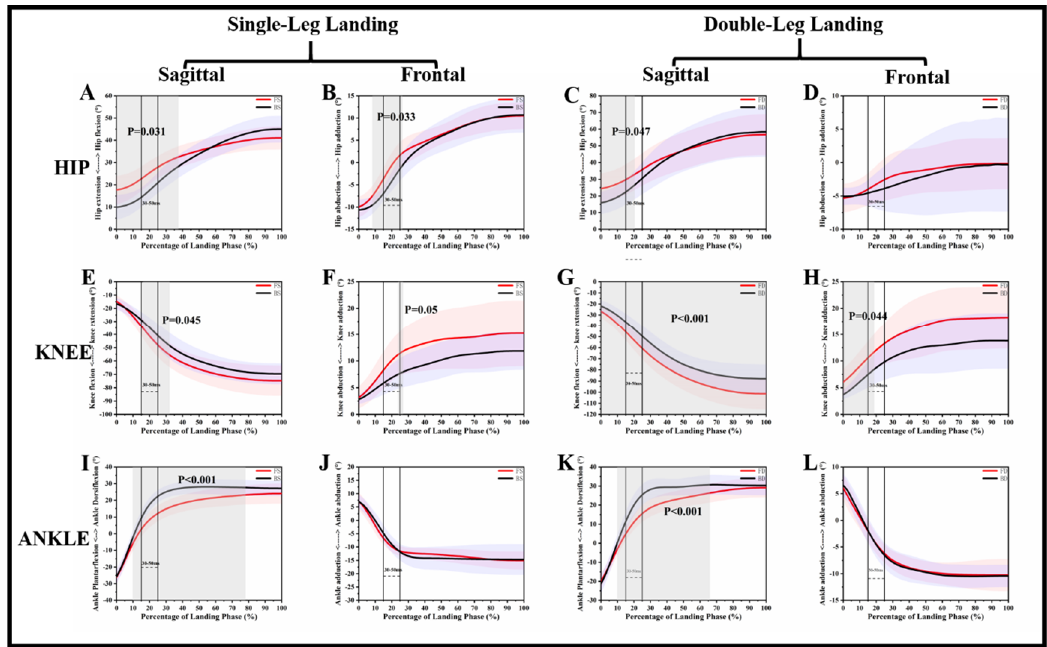
Figure 2. Descriptive results between forward landing and backward landing task statistical parametric mapping results, depicting the hip, knee, and ankle joint in the sagittal and frontal planes and single-leg landing and double-leg landing mean angle trajectories and standard error. The range of the two lines is the time frame between 30 and 50 ms time after landing. Gray shaded areas are statistically different ( p < 0.05) between forward landing and backward landing during the landing phase. A: Hip angle change in Sagittal plane during single leg landing; B: Hip angle change in Frontal plane during single leg landing; C: Hip angle change in Sagittal plane during double leg landing; D: Hip angle change in Frontal plane during double leg landing; E: Knee angle change in Sagittal plane during single leg landing; F: Knee angle change in Frontal plane during single leg landing; G: Knee angle change in Sagittal plane during double leg landing; H: Knee angle change in Frontal plane during double leg landing; I: Ankle angle change in Sagittal plane during single leg landing; J: Ankle angle change in Frontal plane during single leg landing; K: Ankle angle change in Sagittal plane during double leg landing; L: Ankle angle change in Frontal plane during double leg landing. FS: forward single-leg landing; FD: forward double-leg landing; BS: backward single-leg landing; BD: backward double-leg landing.